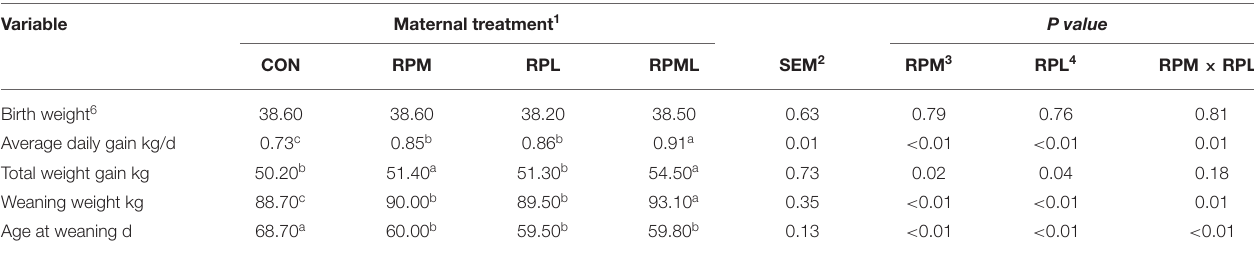
TABLE 5 | Effect of maternal supply of ruminally protected lysine or methionine and combination to pre-calving Holstein dairy cows on the growth performance of their heifer calves 1 .